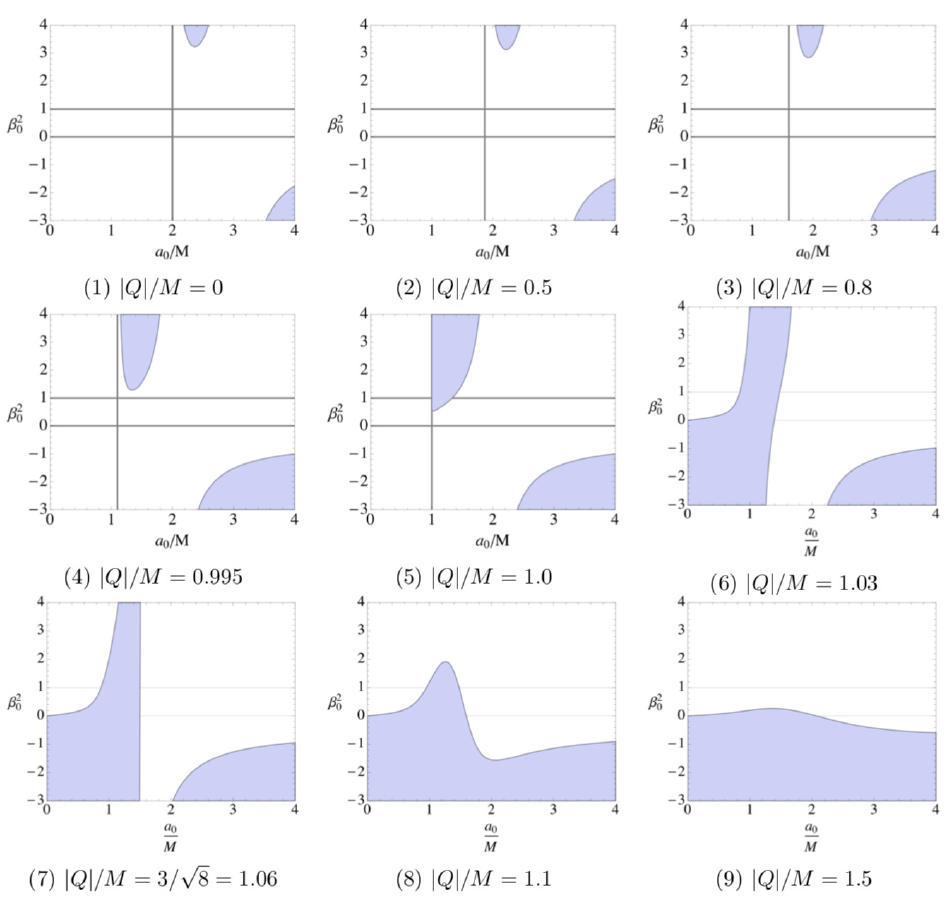
Figure 9. Charged thin-shell wormholes. Shaded regions correspond to stable regions. The outer (cid:112) horizon r + corresponds to r + / M = 1 + 1 − | Q | 2 / M 2 ; therefore, the regions inside of the outer horizons (vertical lines) have no physical meaning in these figures when 0 ≤ | Q | / M ≤